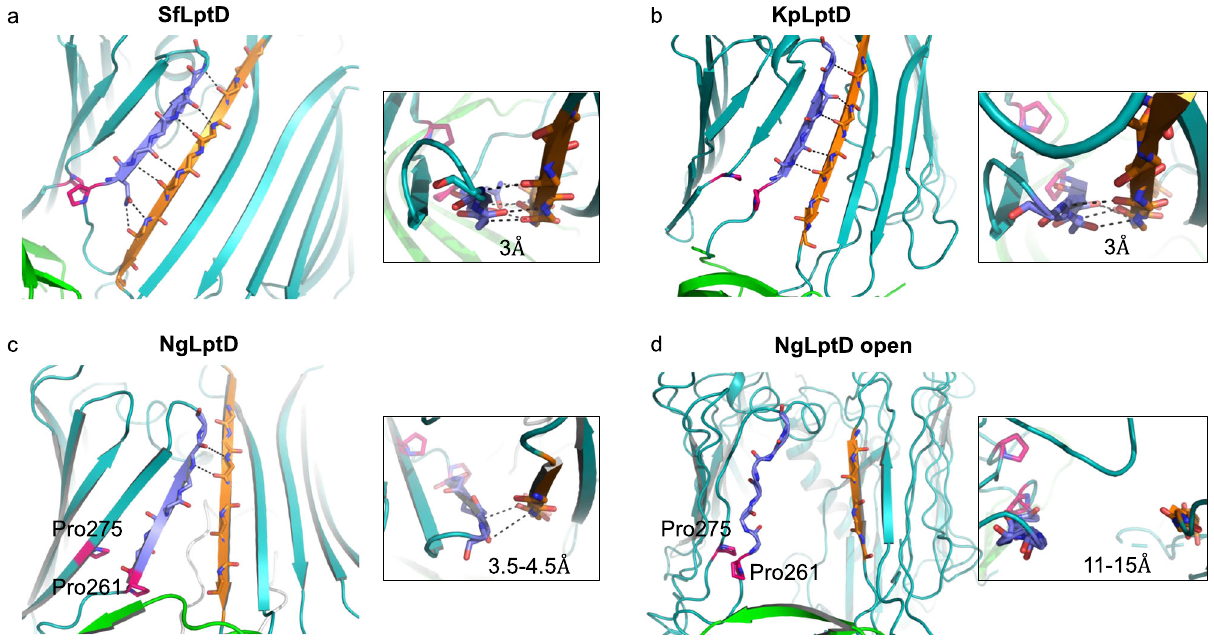
Fig. 4 Hydrogen bonds between the β -strands 1 and 26 in structures of the LptD barrel. a SfLptDE, ( b ) KpLptDE (PDB-ID 5IV9), ( c ) NgLptDE (partially open), and ( d ) NgLptDE (open lateral gate). Distances between the terminal strands are indicated and small insets show a view from extracellular. β -strand 1 and β 26 are shown in light blue and orange, respectively, and the conserved proline residues of β -strands 1 and 2 in